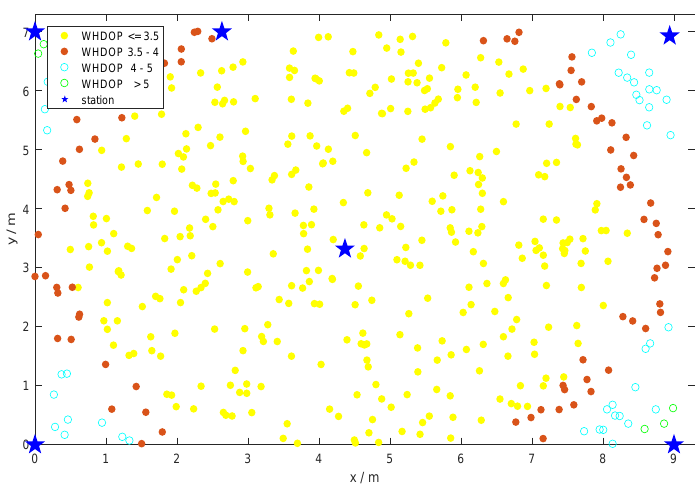
Figure 5. WHDOP distribution map of 6 pseudolites.